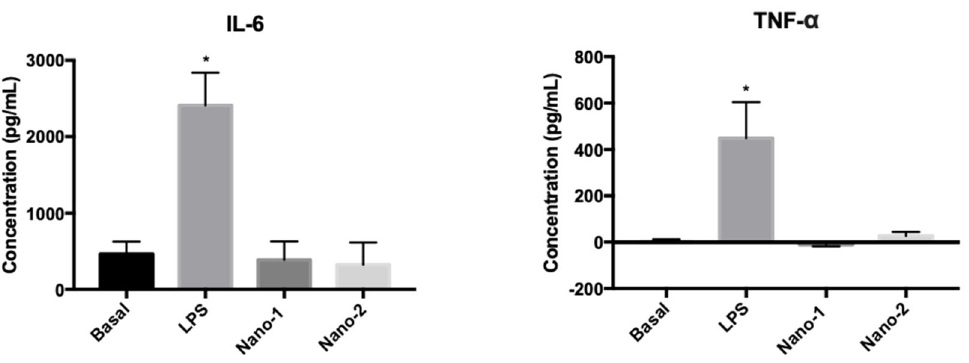
Figure 5. IL-6 and TNF- α production induced by treating human macrophages with LPS (positive control) and nanoemulsions. Results were statistically analyzed by ANOVA, followed by Tukey’s test. (*) indicates statistically significant difference with P < 0.05 (n = 3 determinations).